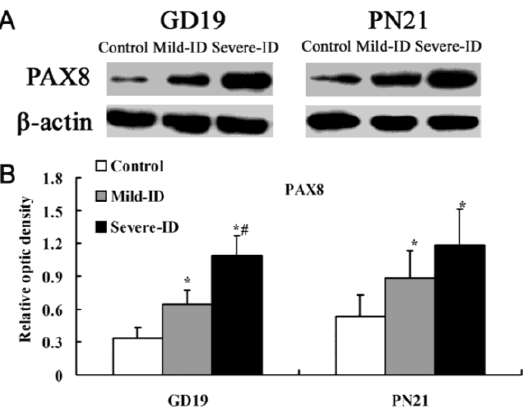
Figure 4. Up-regulated protein levels of PAX8 in the thyroid. The upper bands ( A ) depict representative findings for rats subjected to mild ID and severe ID. The lower bar graphs show the results of the semi-quantitative measurement of PAX8 ( B ) following mild ID and severe ID treatment. The height of each bar represents the mean ±SD for the groups. At each time point, * compared to the control, p < 0.05; # compared to the mild ID, p < 0.05 (n =